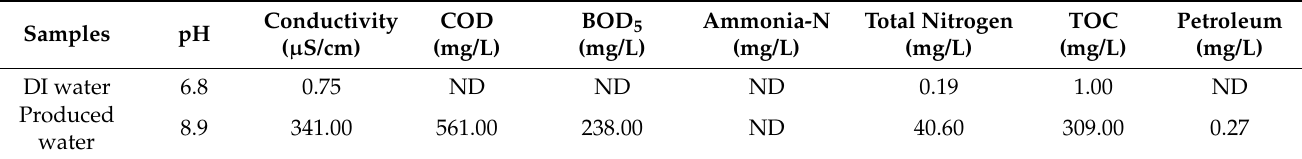
Table 1. Water quality of DI water and produced water.